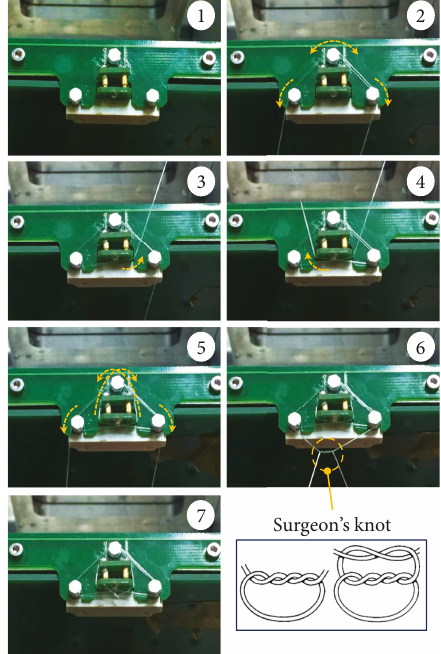
Figure 5: An optimized tightening process of the nylon cable demonstrated along three guide pins of the